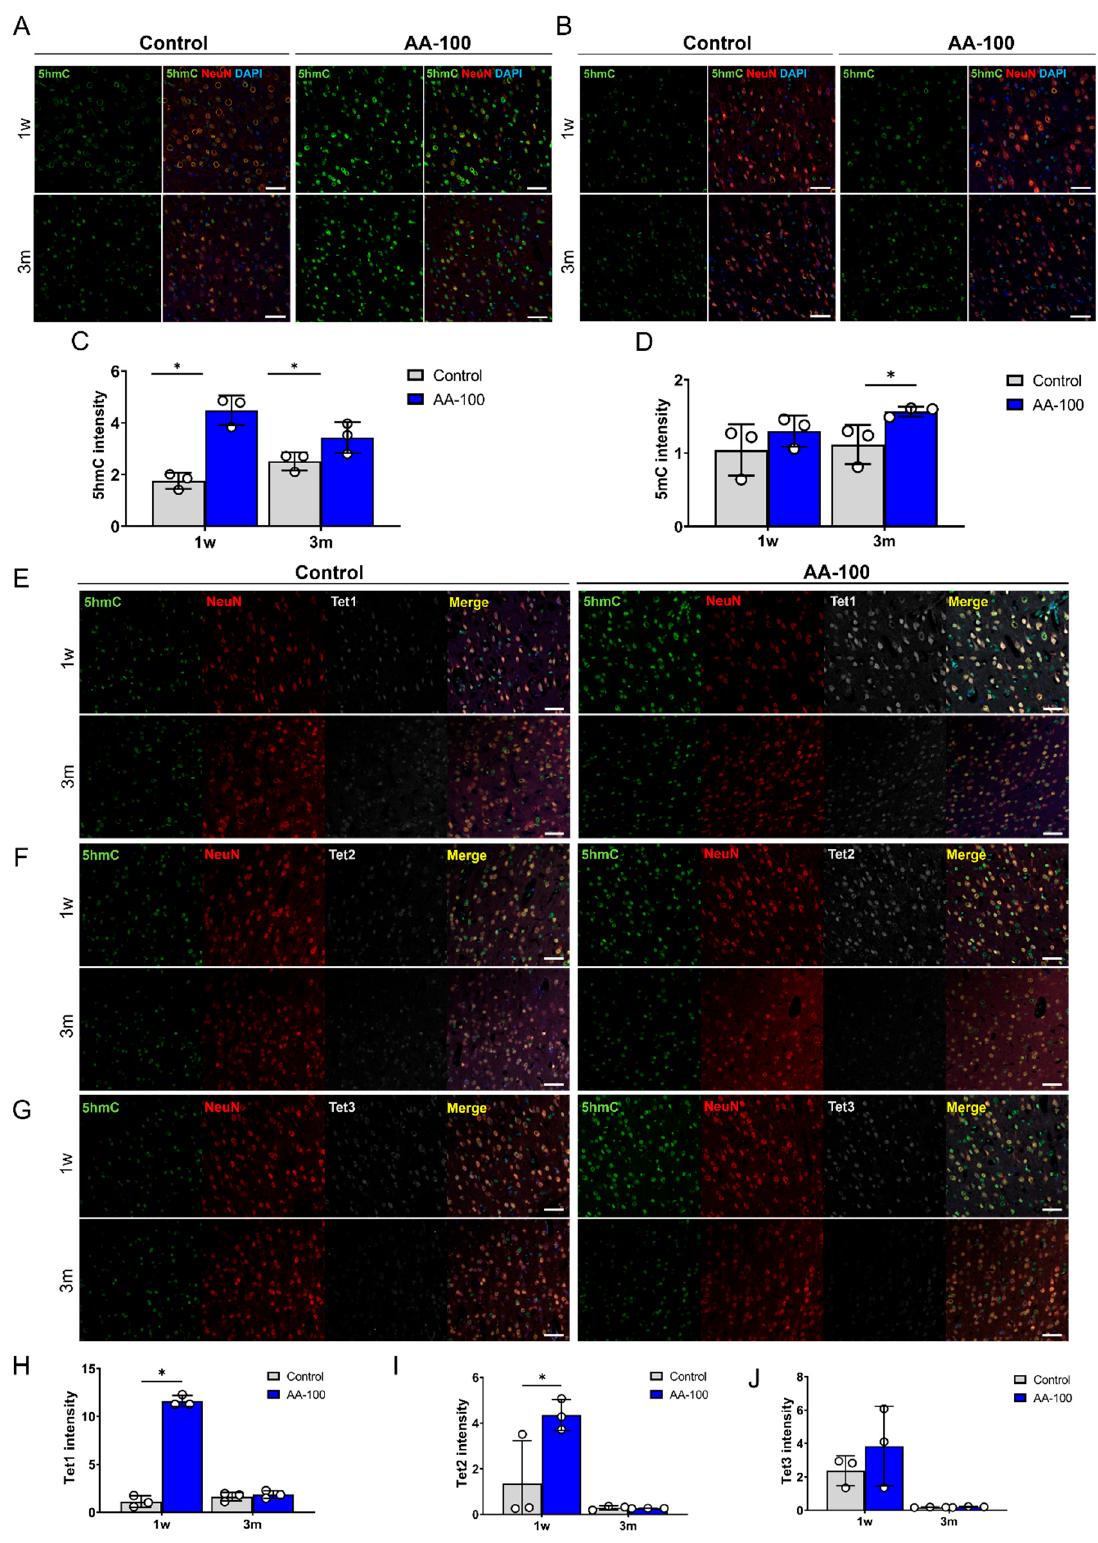
Figure 4. ( A , B ) Representative immunohistochemical images showing double staining of 5hmC (green) and NeuN (red) ( A ), and of 5mC (green) and NeuN (red) ( B ) in the primary motor cortexes of rats in the control and AA-100 groups 1 week (1 w) and 3 months (3 m) after injury. White scale bars = 50 µ m. ( C , D ) The 5hmC ( C ) and 5mC ( D ) intensity in neurons in the primary motor cortexes of rats in the control ( n = 3) and AA-100 ( n = 3) groups 1 w and 3 m after injury; * p < 0.05 between the control and AA-100 groups at the same time point by Mann-Whitney U test. ( E – G ) Representative immunohistochemical images showing triple staining of Tet1 (gray), 5hmC (green), and NeuN (red)